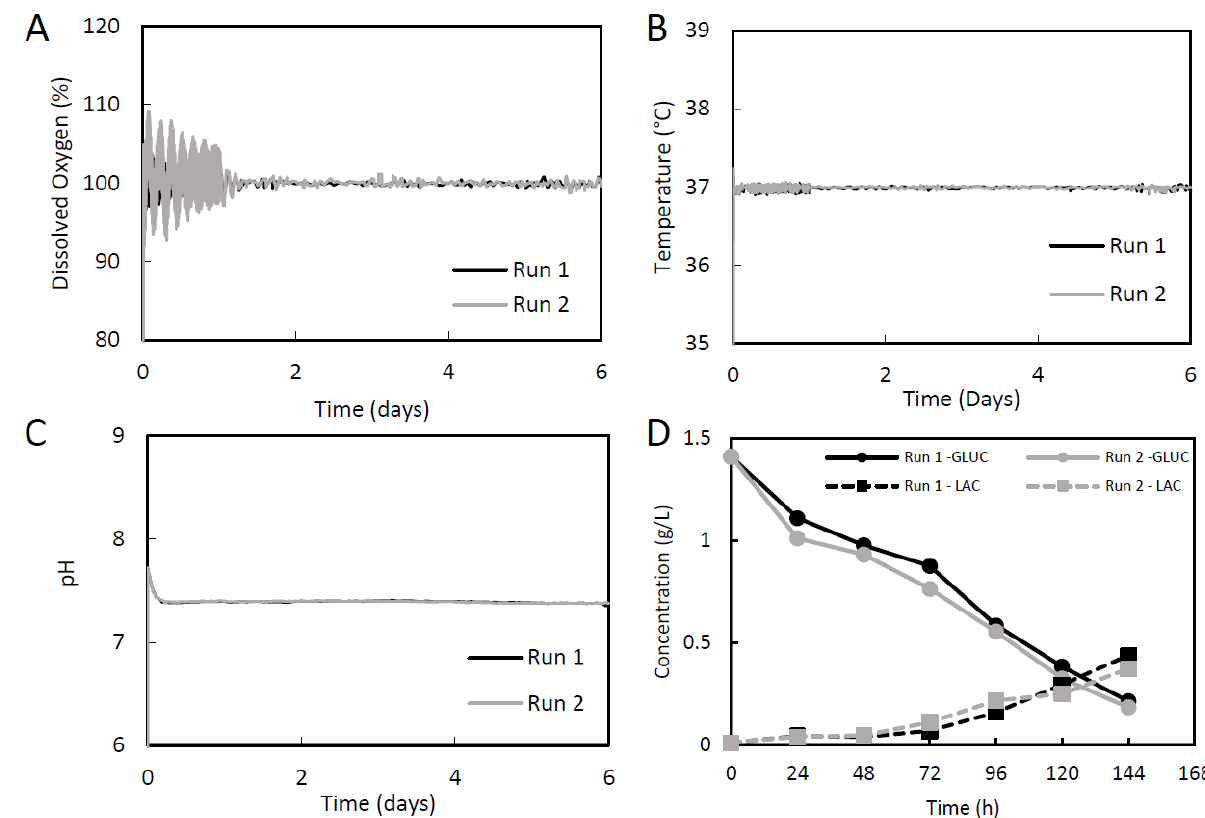
Figure 4. Process parameters and metabolism of Sk-SCs expanded in 500 mL DASGIP bioreactors.